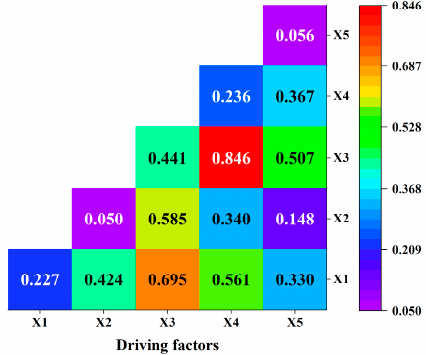
Figure 4. Interaction of ANSP detection factors. Table 9. The intensity of action of ANSP detection factor q .